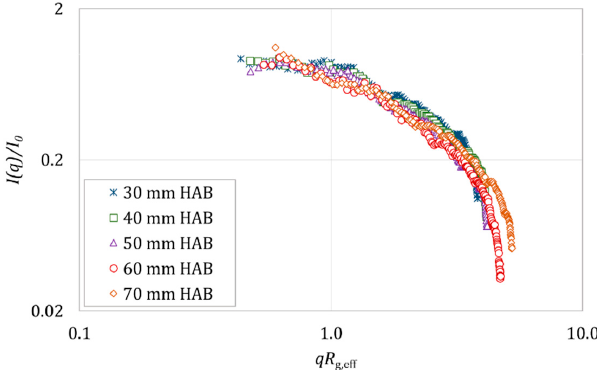
Figure 12. Comparison of single-shot scattering data versus qR g,eff from 30 to 70 mm above the burner. The scattering data can be evaluated in the Guinier regime.